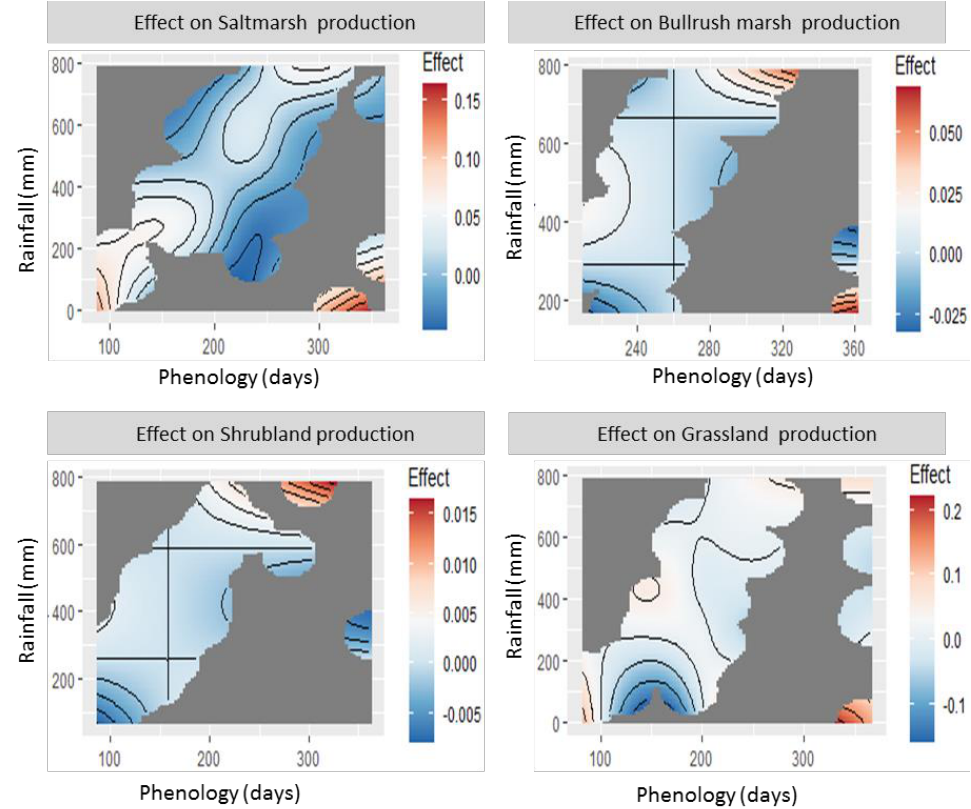
Figure A3. Effect of the interaction between rainfall and phenology in the GAM models adjusted to the production (peak NDVI) of the four main vegetation types consumed by wild and domestic ungulates at the study area (Doñana National Park). The plot differs from Figure 3 in showing the effect of the interaction factor without the effect of the main factors. Note that the color palette varies among graphs, i.e., the same color does not indicate the same range of production values (as indicated by the contour plots) in all graphs.